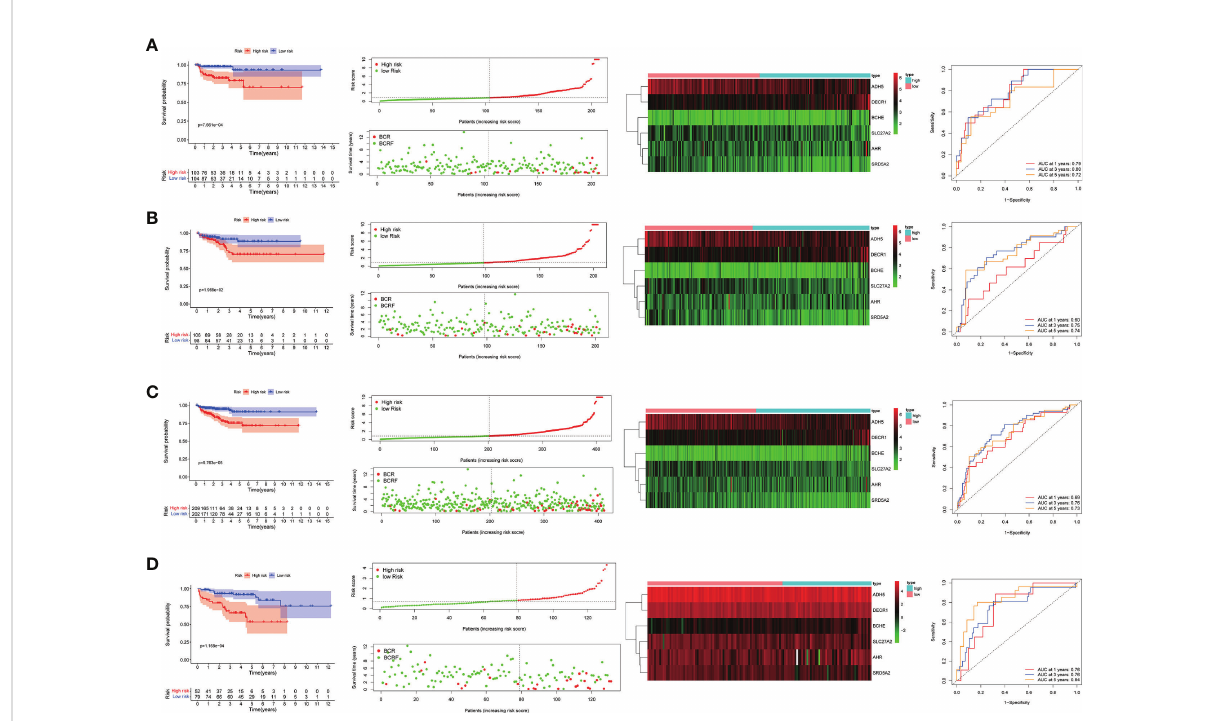
FIGURE 4 (A – D) . Predictive value of genetic characteristics for biochemical relapse (BCR) in each cohort. risk scores were signi fi cantly higher in patients with BCR disease than in patients without BCR disease. Kaplan-Meier analysis showed that relapse-free survival (RFS) was signi fi cantly longer in patients with low risk scores than in patients with low risk scores. Time-related subject operating curve (ROC) analysis showed that each group predicted 1-, 3-, and 5-year bRFS.